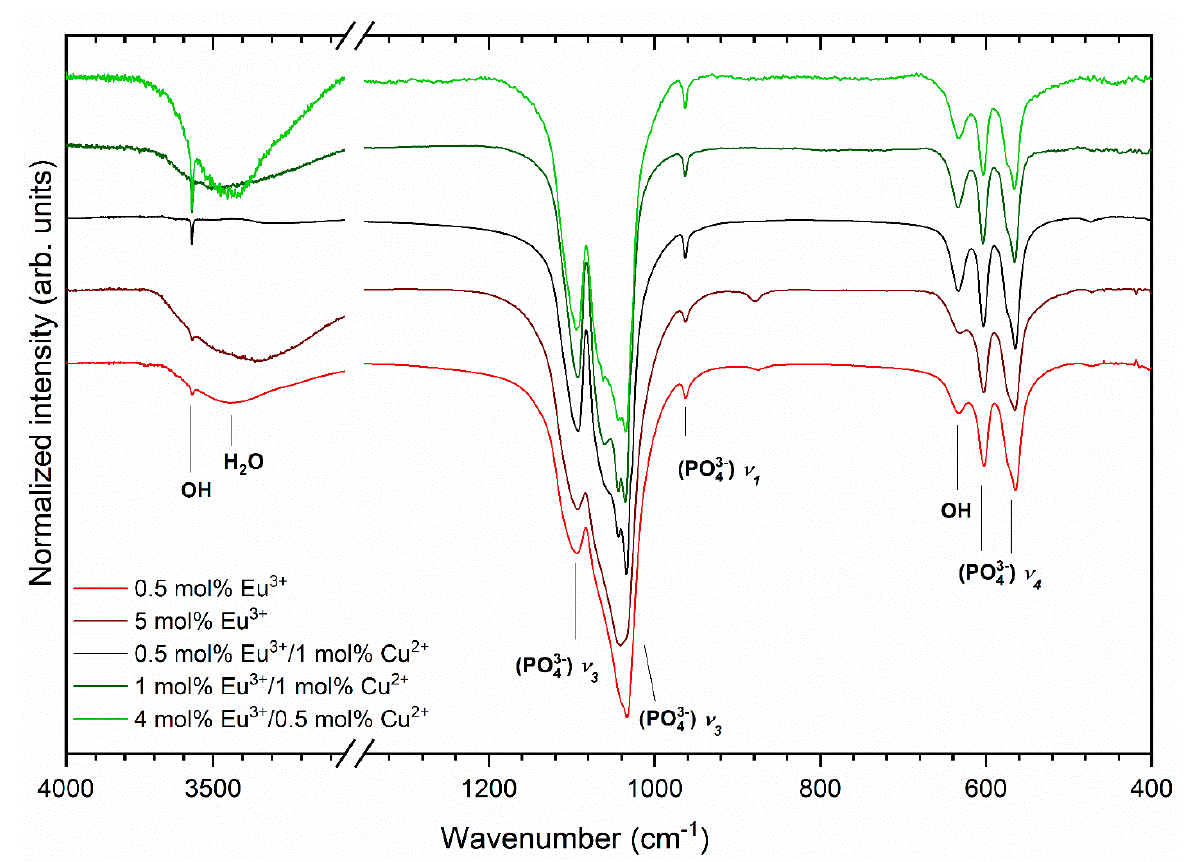
Figure 4. Infrared spectra of the Eu 3+ -doped and Eu 3+ /Cu 2+ co-doped Ca 10 (PO 4 ) 6 (OH) 2 .